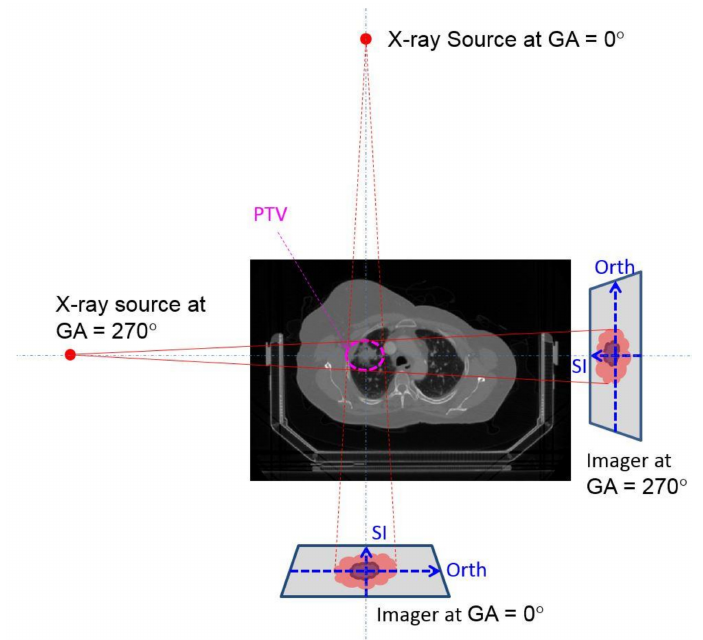
Figure 1. Schematic diagram of the imaging geometry. The X-ray source and imager are mounted on a gantry rotating around a horizontal axis, patient’s superior–inferior (SI) direction. X-ray source and imager at gantry angle (GA) of 0 ◦ and 270 ◦ are superimposed. The lung tumor is expanded to a planning target volume (PTV) as demonstrated. The projection image of both PTV and tumor is illustrated on the imager. Imager has two axes: the superior–inferior (SI) direction always coincides with the patient’s SI axis, while the Orth axis changes in a 3D space with gantry rotation.